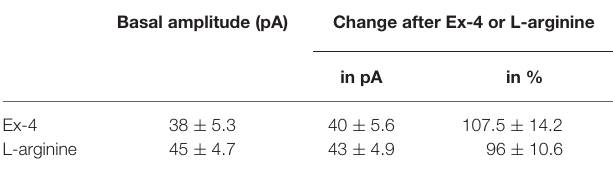
TABLE 5 | Changes in mPSC amplitude on GnRH neurons upon application of Exendin-4 or L-arginine. Basal amplitude (pA) Change after Ex-4 or L-arginine in pA in %